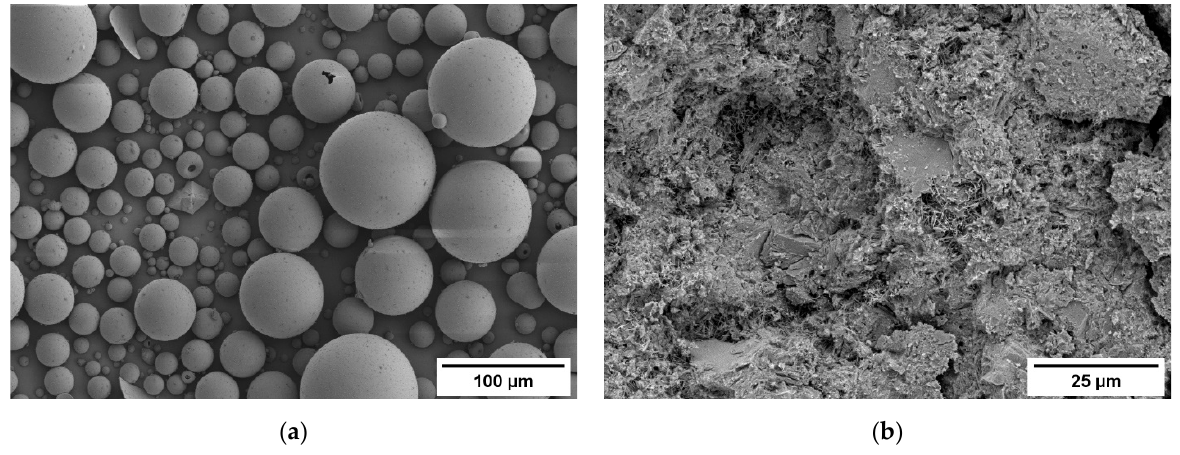
Figure 4. ( a ) SEM image of HGMSs. The acceleration voltage was set to 3 kV, while a SE detector was used. ( b ) SEM image of the hydrated CSA cement (sample 100C) after storage for 14 days in a moist atmosphere. The acceleration voltage was set to 5 kV, and again a SE detector was used.